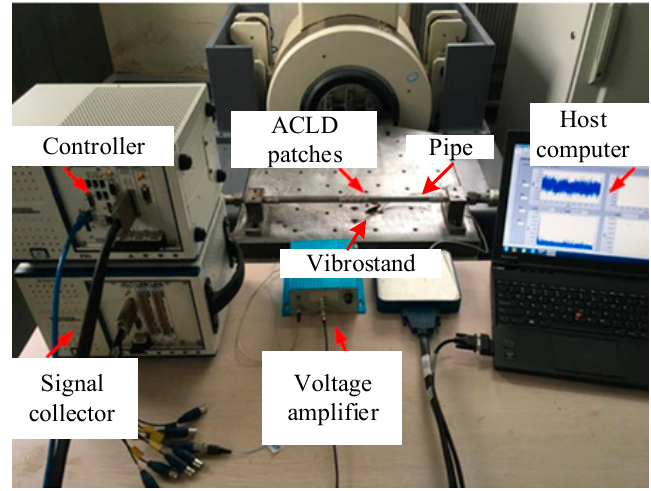
Figure 10. Diagram of experiment platform.